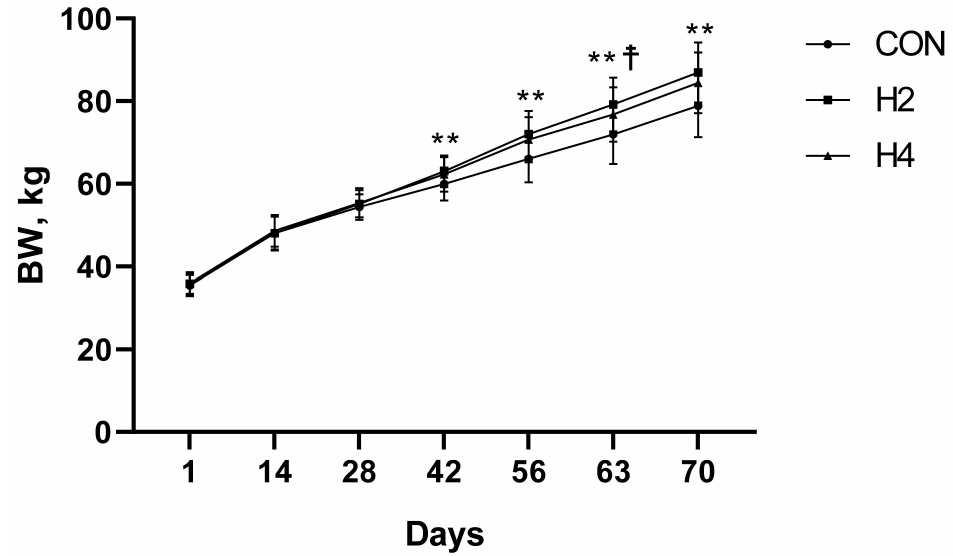
Figure 1. Mean BW for Holstein female calves fed a basic diet without (CON: solid circles; n = 70) or with hay inclusion from the second (H2; Solid squares; n = 70) or fourth (H4; Solid triangles; n = 70) week of age. Differences between CON and hay groups are represented by an asterisk ( p < 0.05, denoted by **). Differences between H2 and H4 are represented by a cross ( p < 0.05, denoted by ☨ ).